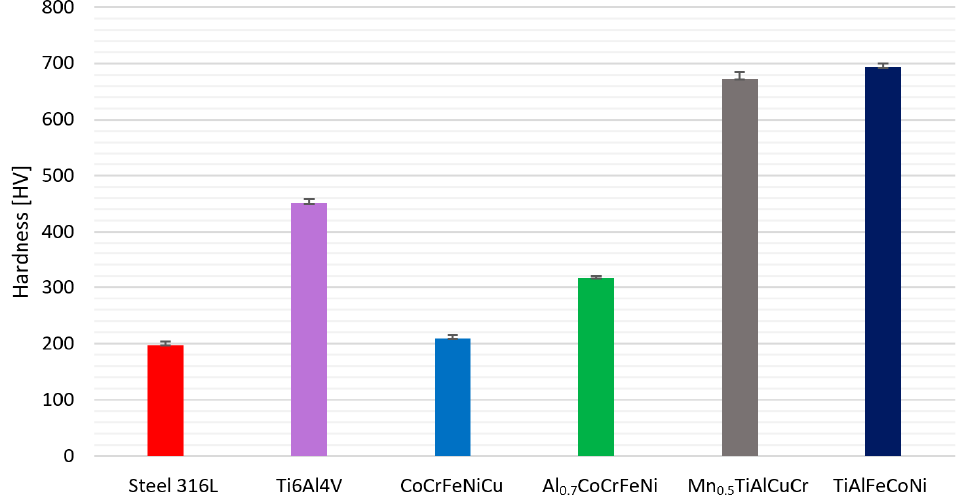
Figure 5. The average hardness of tested alloys.